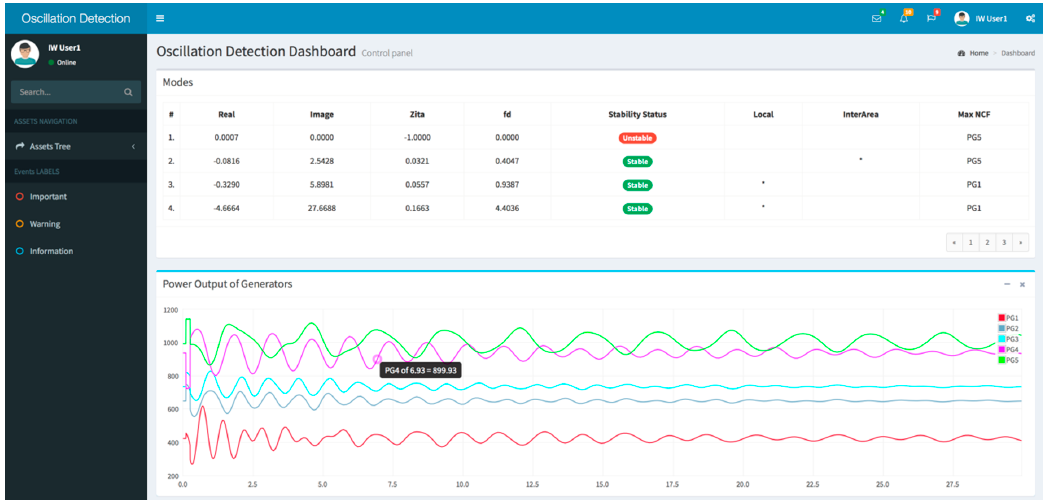
Figure 11. A schematic of the power system oscillation detection application.